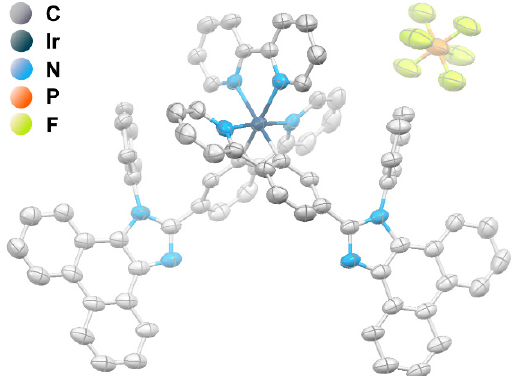
Figure 1. Perspective view of 2 in the solid state showing thermal ellipsoids at the 40% probability level. Hydrogen atoms are omitted for clarity.